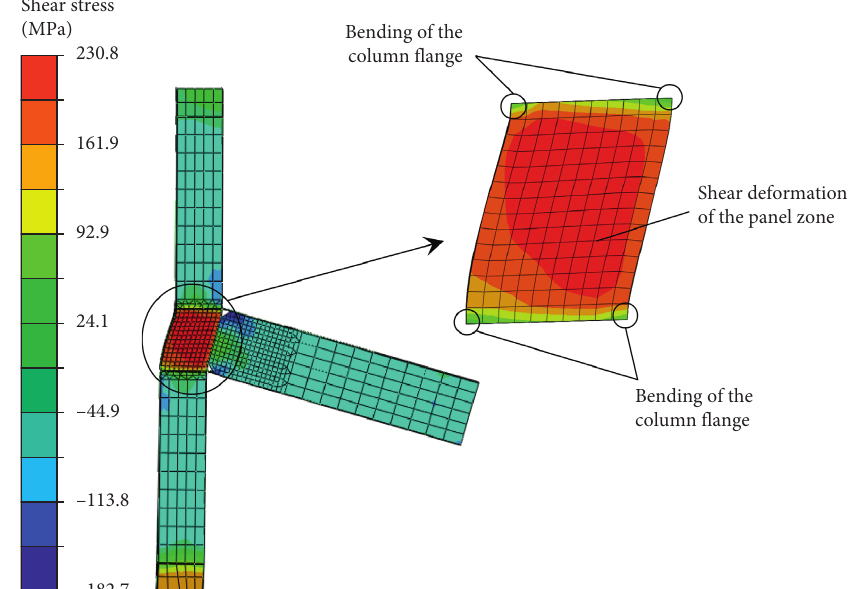
Figure 5: Deformation of the beam-column connection ( P